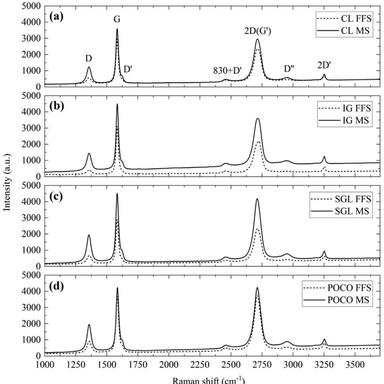
Averaged Raman spectra for the four grades of graphite after baseline subtraction showing the characteristic Raman bands from machined surfaces (MS) and freshly fractured surfaces (FFS) for (a) CL 2020, (b) IG 430, (c) SGL R7650, and (d) POCO ZXF-5Q.